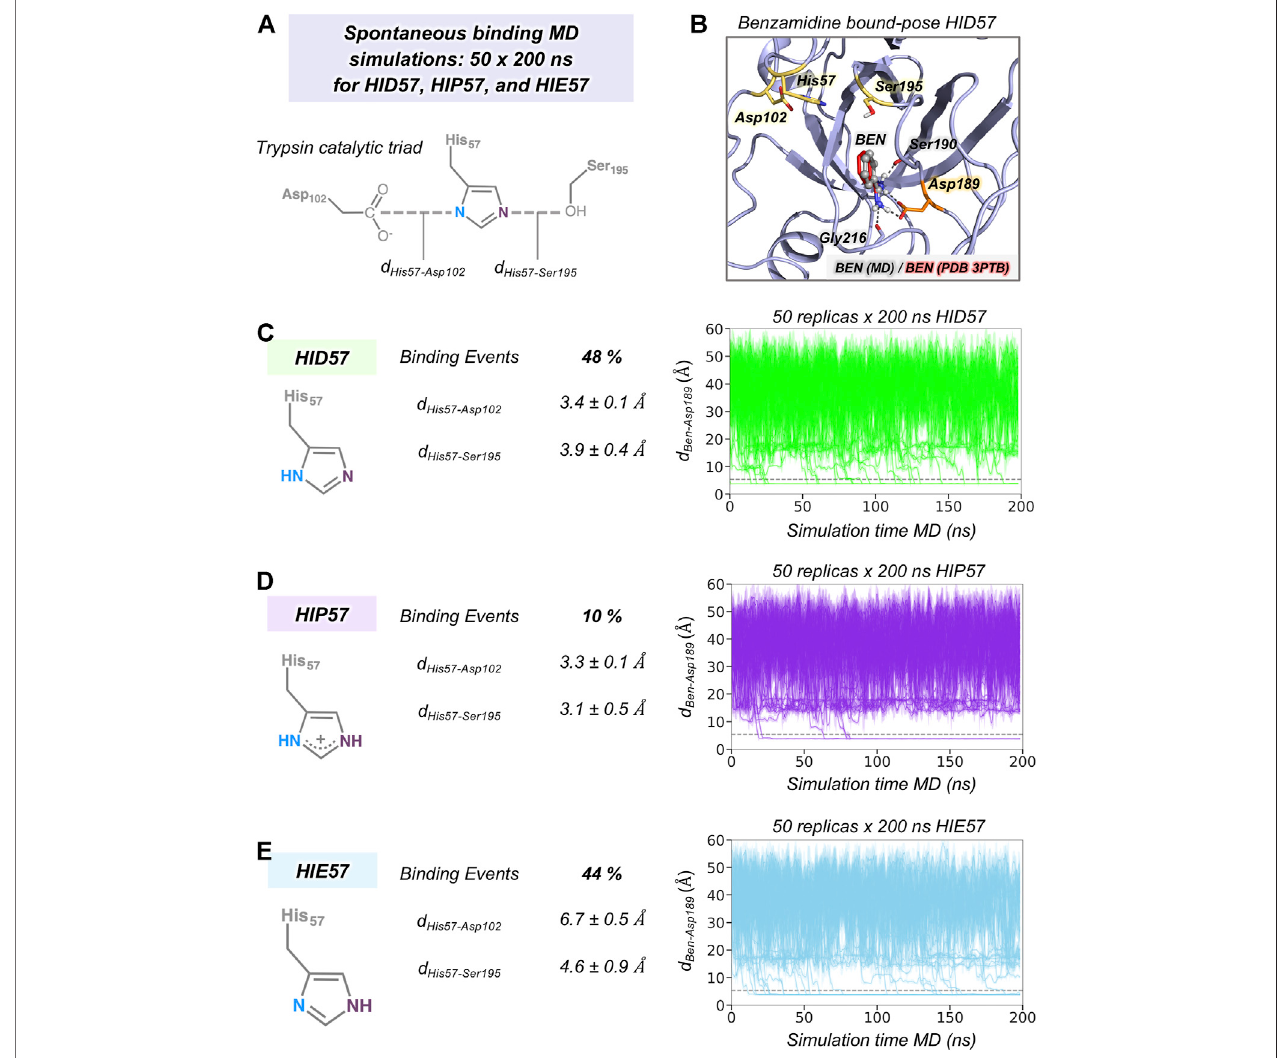
FIGURE 2 | The effect of His57 protonation in benzamidine binding. (A) Representation of the trypsin catalytic triad formed by Asp102, His57, and Ser195. The distance between Asp102 and His57 residues is calculated between the carbon of the carboxylate group of Asp102 and the delta nitrogen of His57. The distance between His57 and Ser195 iscalculated between the epsilonnitrogen of His57 and theoxygen ofthe hydroxylgroup of Ser195. (B) Representative conformation of the trypsin-benzamidine bound complex predicted from spontaneous binding HID57 MD simulations. The binding pose of benzamidine obtained from molecular dynamics(MD)simulationsisshowningreywhiletheX-rayorientation(PDB3PTB)isdepictedinred.CatalyticresiduesandAsp189arecolouredinyellowandinorange, respectively. (C) Analysisof50replicasof200 nsofHID57MDsimulationswiththedeltanitrogenofHis57protonated. (D) Analysisof50replicasof200nsofHIP57MD simulations with His57 positively charged. (E) Analysis of 200 ns of HIE57 MD simulations with the epsilon nitrogen of His57 protonated. The percentage of binding events and the average distances (in Å) between catalytic residues is provided for each protonation state. Plot of the distance between the carbon atom of the amidine groupofbenzamidineandthecarbon ofthecarboxylate groupofAsp189sidechainalongthe50replicas of200 nsMDsimulations foreach protonationstate. Thegrey horizontal dashed line indicates when productive benzamidine binding takes place (distance below 5.4